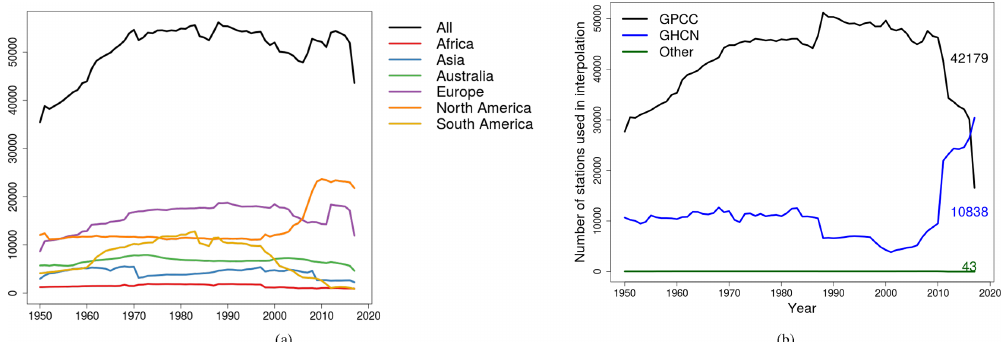
Figure 1. Final (interpolated), quality-controlled number of stations over time by (a) region and (b) source. Figure 4c shows a map of the regions. Due to the varying station network over time, the total number of stations over the entire temporal domain sums to 135178 stations. The numbers in black, blue and green in (b) refer to the average number of stations from GPCC, GHCN and Other sources respectively.